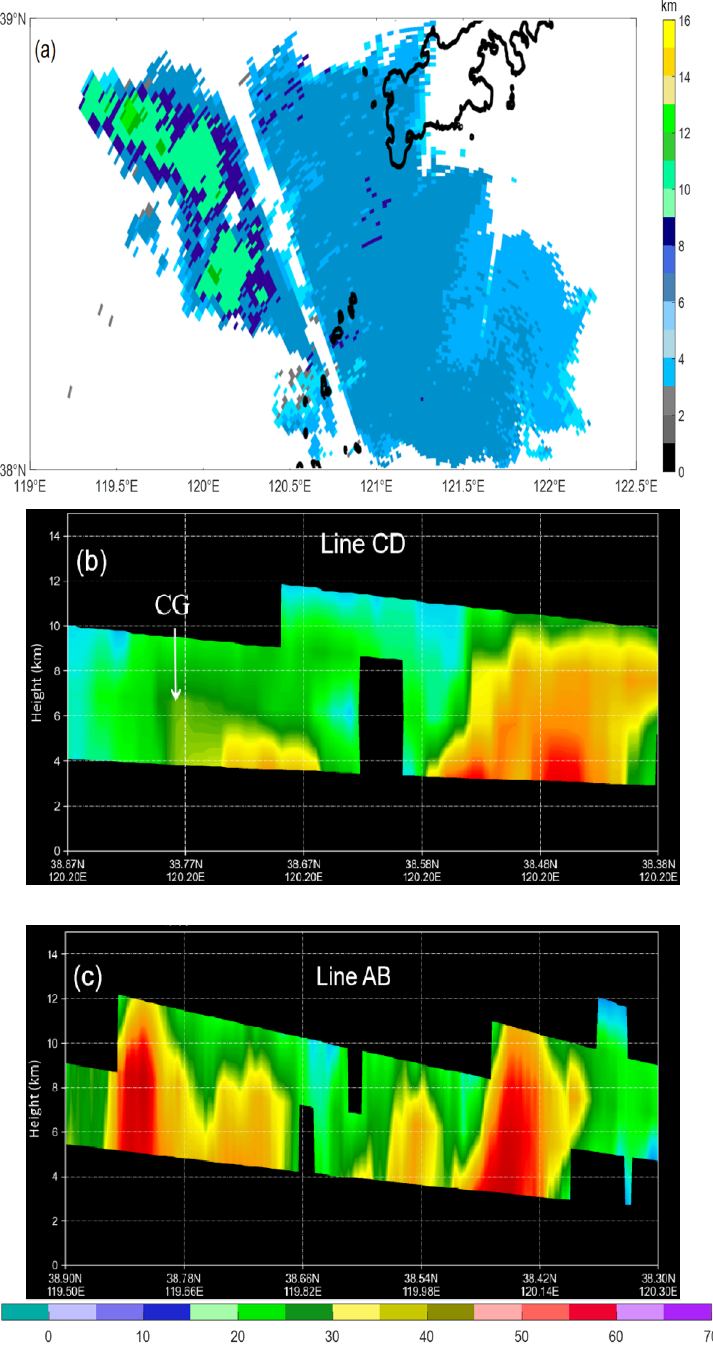
Figure 12. ( a )The radar echo top height at 16:45, the parent CG is labeled by “+” and marked as CG. ( b ) and ( c ) are the vertical sections along lines AB and CD (in Figure 11).